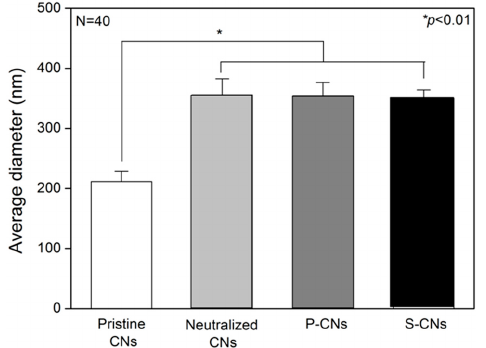
Figure 2. Average fiber diameters of CNs. The average diameter of nanofibers was determined by selecting 10 fields from each image and manually measuring fiber diameters.